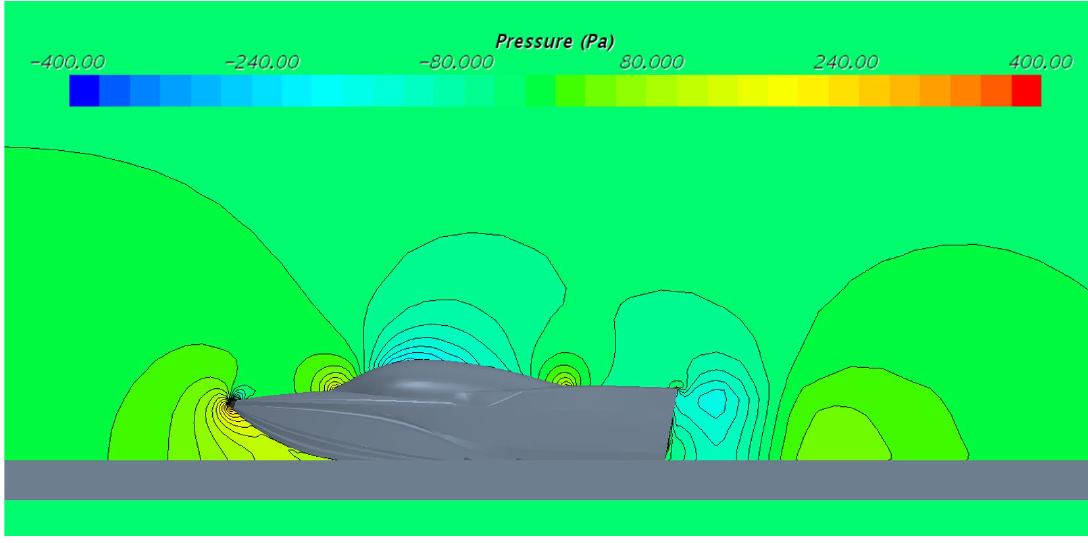
Figure 9. Pressure distribution in middle longitudinal profile of each model at 25 m/s: ( a ) Model A01; ( b ) Model A02; ( c ) Model B01; ( d ) Model B02; ( e ) Model C01; ( f ) Model C02; ( g ) Model D01; and ( h ) Model D02.